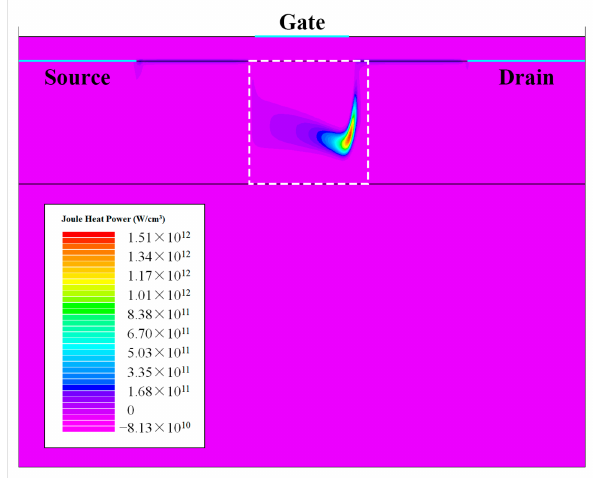
Figure 5. Joule heat power profile in the device at the gate-to-source bias of 0 V and drain-to-source bias of 25